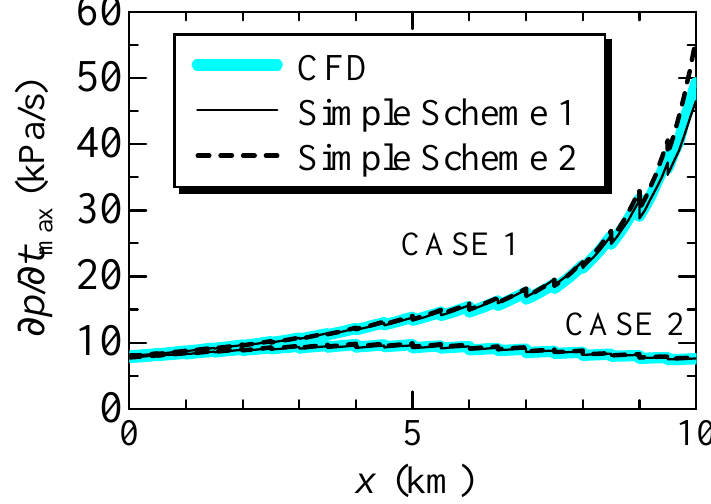
Fig. 7 Comparison of maximum values of pressure